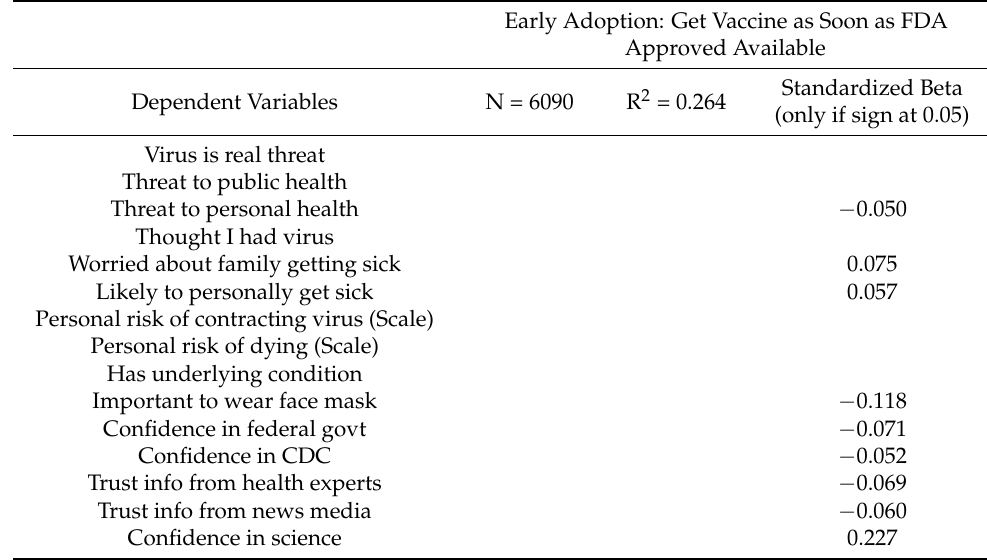
Table 7. Regression of Likelihood of Vaccine Adoption (Very, Somewhat, Not Too, Not at All) by Risk and Trust